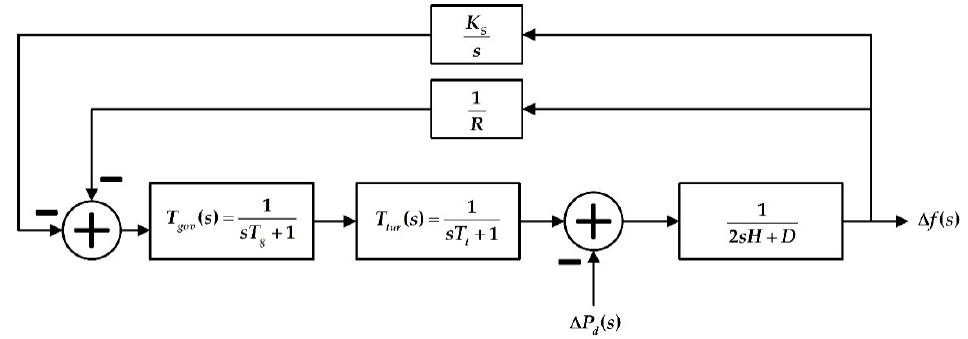
Figure 3. Block diagram of a power system with primary and supplementary control loops.